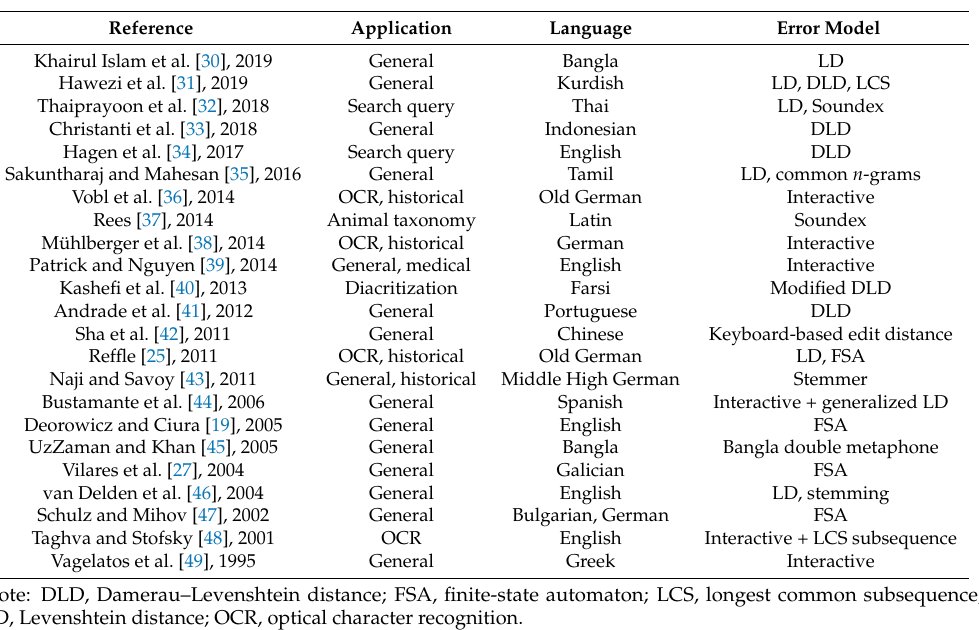
Table 2. Summary of a priori spelling correction systems.